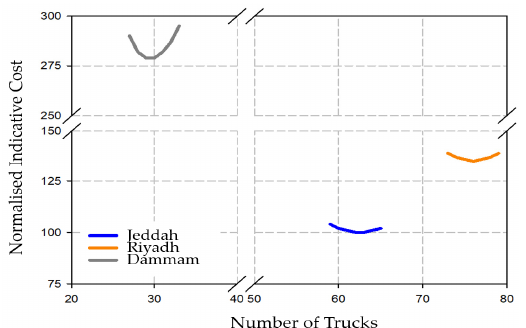
Figure 10. Normalised indicative cost as a function of number of trucks in Jeddah, Riyadh and Dammam warehouses.